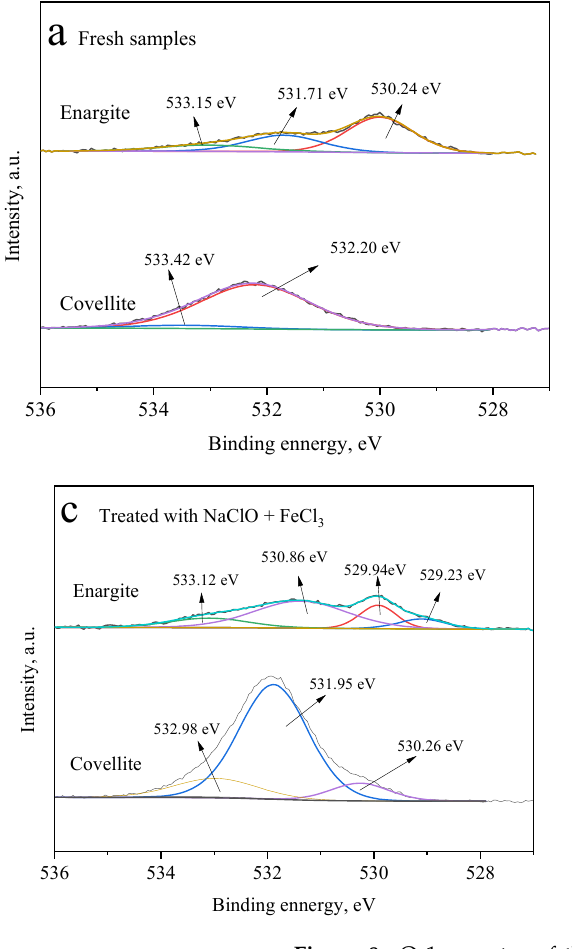
Figure 8. O 1s spectra of the covellite and enargite samples treated with different depressants: ( a ) fresh samples, ( b ) NaClO, and ( c ) NaClO + FeCl 3 . With or without depressants, only one pair of characteristic peaks is noted in the S 2p3/2 spectra of enargite (Figure 9), indicating the absence of sulfur oxidation products on the surface. However, five pairs of peaks are noted at 161.28 ± 0.2, 162.1 ± 0.2, 163 ± 0.2, 165 ± 0.2, and 168 ± 0.2 eV on the covellite surface, which are assigned to S 2 − , S 22 − , S 0 /Sn 2 − , SO 32 − , and SO 42 − , respectively [15,29]. Hydrophilic sulfides of SO 32 − and SO 42 − are important for the hydrophilicity of covellite surfaces. After the treatment with NaClO alone, the sulfur oxides account for 46.13 at% of the total sulfur content. When FeCl 3 is added, this proportion further increases to 54.35